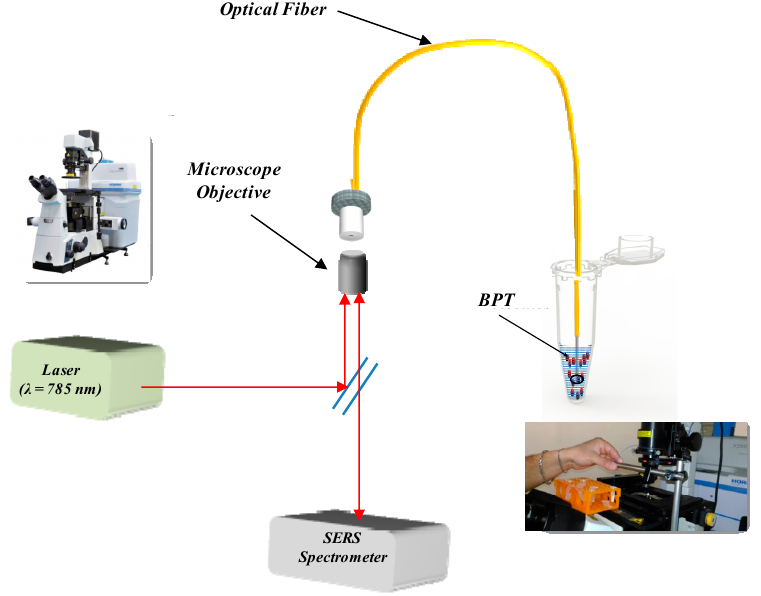
Figure 2. Schematic of the experimental setup for the optical fiber type selection composed by the Xplora Raman microscope (with relative picture) and the optical fiber immersed in the BFT solution (with related picture).